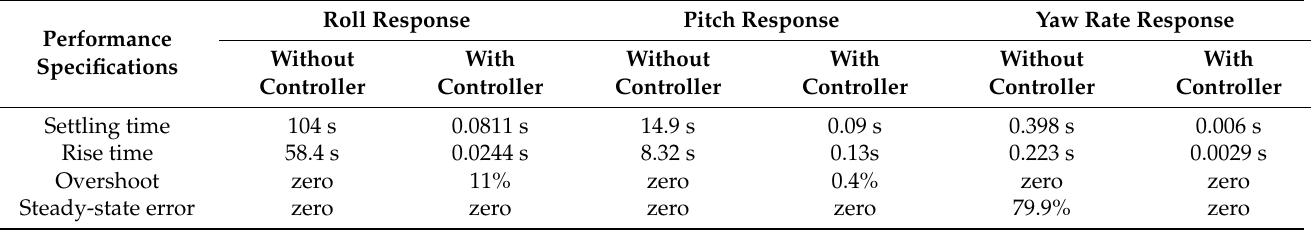
Table 5. Comparison of octocopter responses with and without controller.